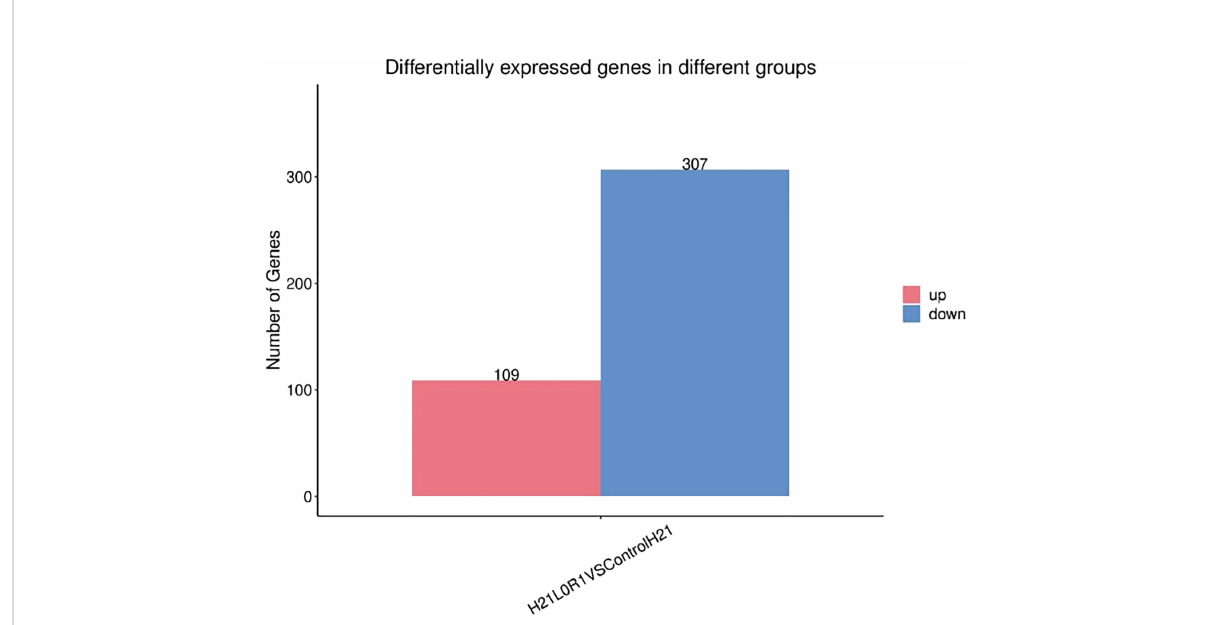
FIGURE 12 Differently expressed genes displayed as a bar graph in the different groups; the two bars showed higher and lower gene expression values in maize